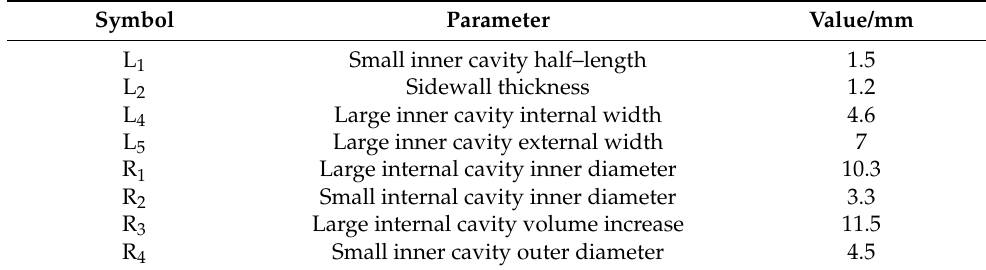
Table 2. Structural parameters of the air